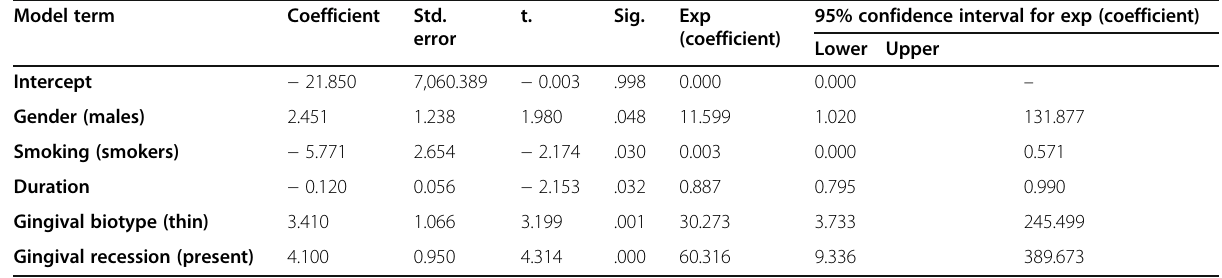
Table 3 Results of multilevel logistic regression (generalized linear) after backward stepwise logistic regression (conditional)